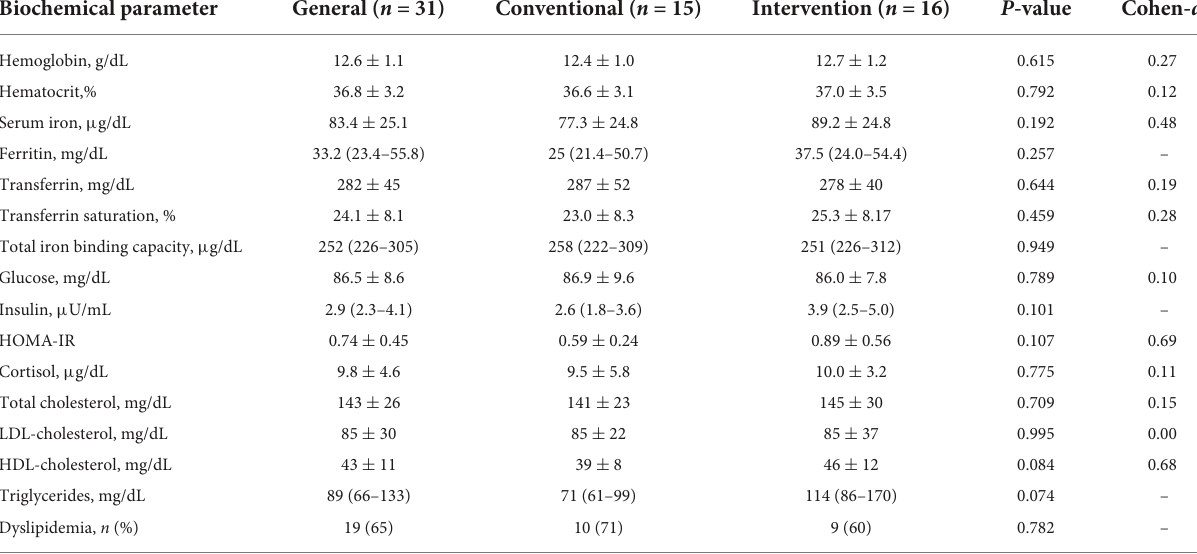
TABLE 3 Biochemical analysis in the follow-up ambulatory care at 24 months corrected the age of preterm infants subjected to an early intervention program compared to conventional care. Biochemical